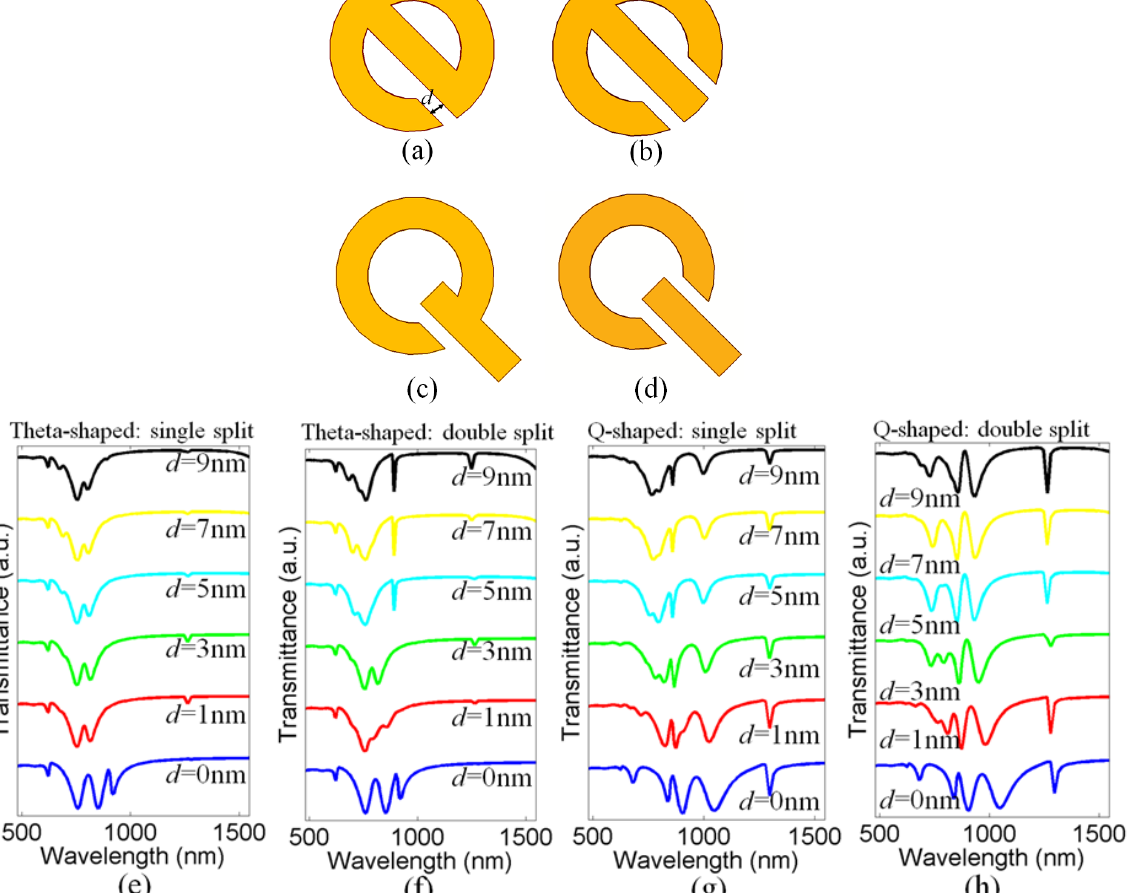
Figure 6. ( a – d ) Schematics of theta ‐ shaped and Q ‐ shaped metasurfaces with single and double splits having size “ d ”; ( e – h ) Transmittance spectra of both the nanostructures at different values of d . Table 4. Q ‐ factor and FoM values around Fano resonances